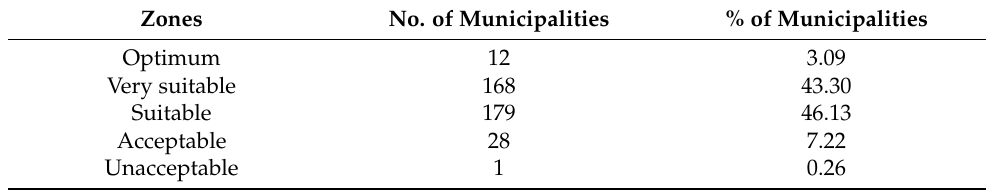
Table 7. Number of municipalities by category of the optimal location